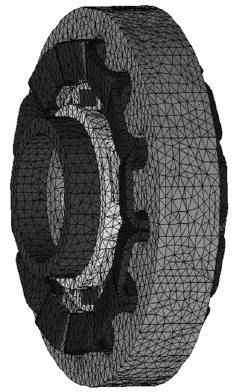
Figure 3. Partial mesh elements for the electromagnetic calculation.